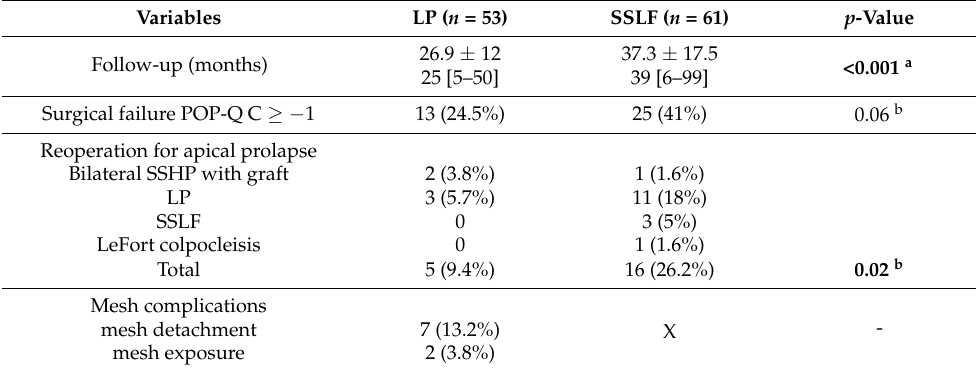
Table 4. Assessment of the surgical effects, reoperations and mesh